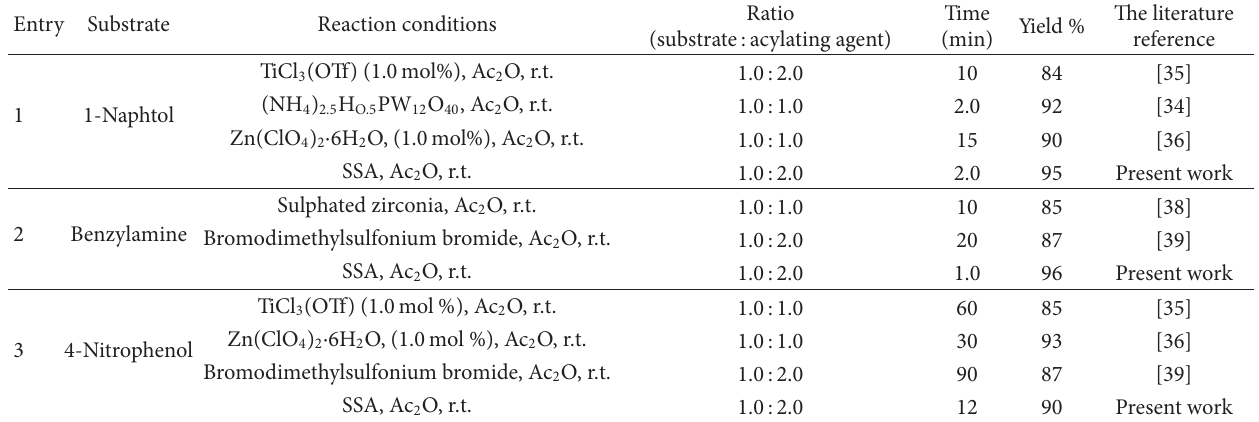
T 5: Comparison of different acylation methods under solvent-free